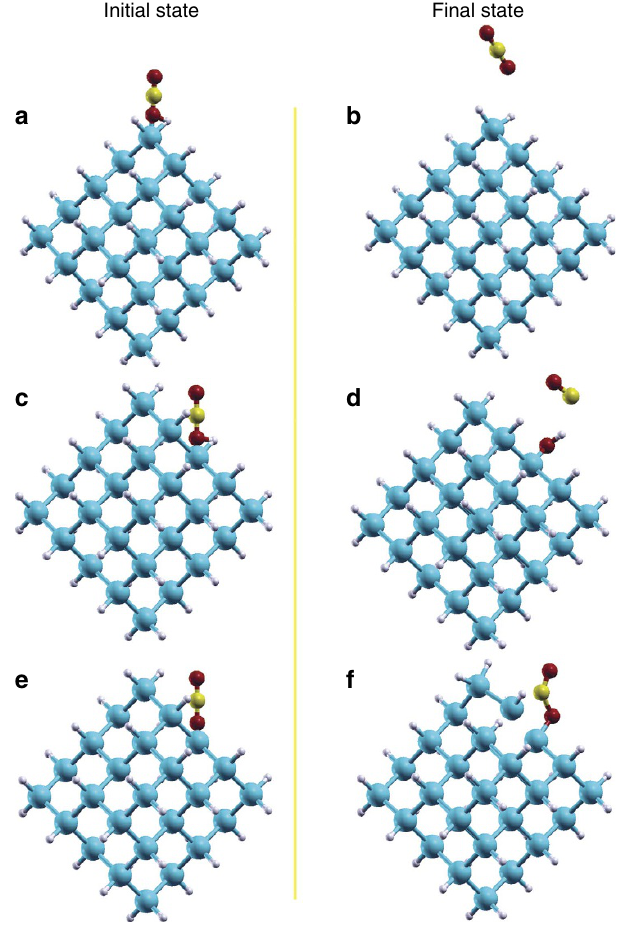
Figure 8 | The DFT models. The initial models of CO 2 adsorption on ( a ) SiH 2 , ( c ) SiH and ( e ) Si surface sites. The final optimized models of CO 2 adsorption on ( b ) SiH 2 , ( d ) SiH and ( f ) Si surface